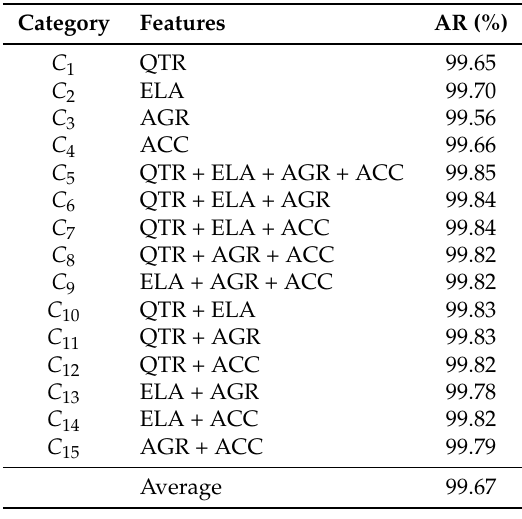
Table 4. Accuracy rates of the trained RNN models using different categories of IMU data with 10-fold cross